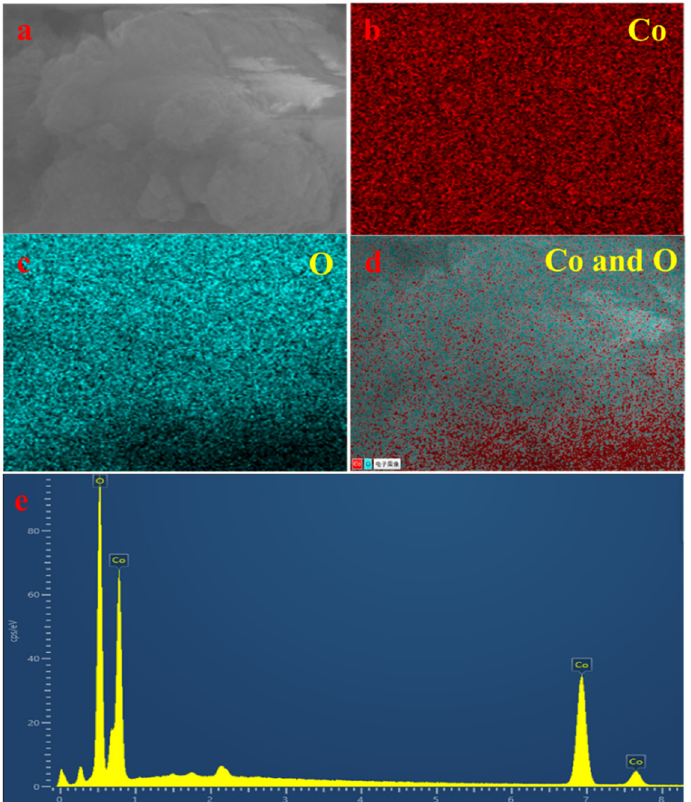
Figure 5. ( a ) SEM image of the selected area for Co 3 O 4 . ( b , c ), and ( d ) show the distributions of Co, O, and both atoms within the selected area, respectively. ( e ) EDS spectrum of Co 3 O 4